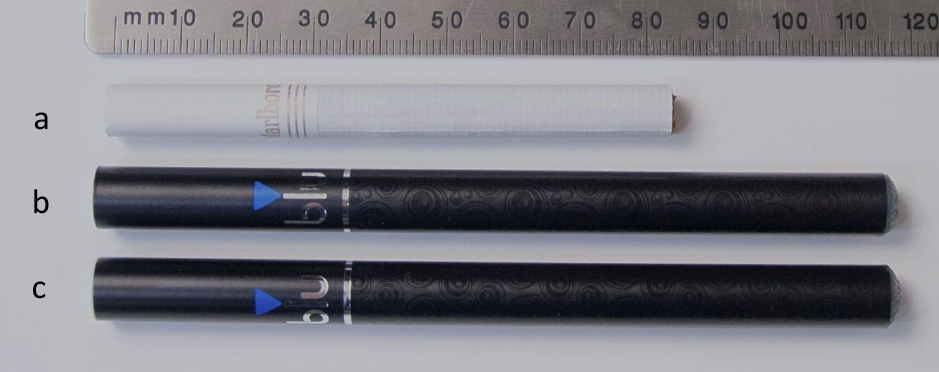
Figure 1. The three study products: ( a ) Marlboro Gold Box, 85 mm conventional cigarette (MGB); ( b ) blu Classic Tobacco Disposabe (blu CTD); ( c ) blu Magnificent Menthol Disposable (blu